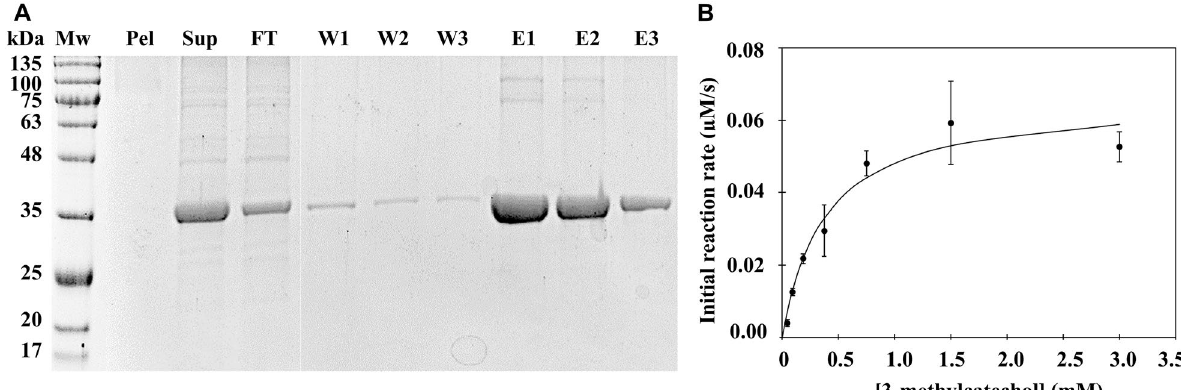
Fig. 2 Purification and characterization of recombinant BLC23O. A Ni–NTA Affinity purification of recombinant BLC23O. SDS–PAGE showing the obtained pellet (P) and supernatant (S) fractions from an E. coli lysate. Subsequent flow-through (FT), washes (W) and elutions (E) are included. The elution fractions were pooled and used in all subsequent experiments. A small portion of the pooled elution was further purified by SEC (Additional file 1: Figure S1). B Kinetic analysis of Ni–NTA SEC purified BLC23O. Following SEC purification, a Michaelis–Menten kinetic analysis of + BLC23O catalytic activity was conducted. BLC23O (18.7 µg/mL) was combined with 10 mM of the co-factor Mn 2 + and varying concentrations of the substrate 3-methylcatechol. The data were fitted to the Michaelis–Menten equation, using Microsoft Excel’s